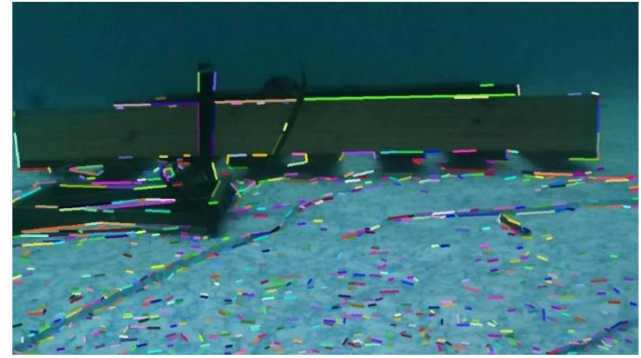
Figure 1. Feature map of underwater extraction